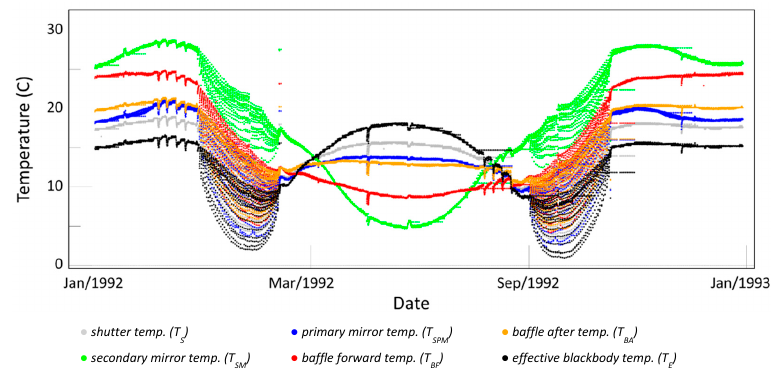
Figure 2. Visible and Infrared Spin Scan Radiometer (VISSR) onboard Geostationary Metrological Satellite-4 (GMS-4) and attachment place of thermometers. (Modified from Figure 7 in [16]). Figure 3 shows the temperatures observed by the five thermometers on the GMS-4/VISSR instrument. During eclipse seasons (around 21 March and 21 September) diurnal variations were observed in the instrument temperatures. The observations of these five thermometers were used to calculate the effective blackbody temperature and to create the operational calibration tables for each full disk observation (slot). These tables were used to significantly reduce biases on observed temperatures caused by diurnal variations in sensor temperature.